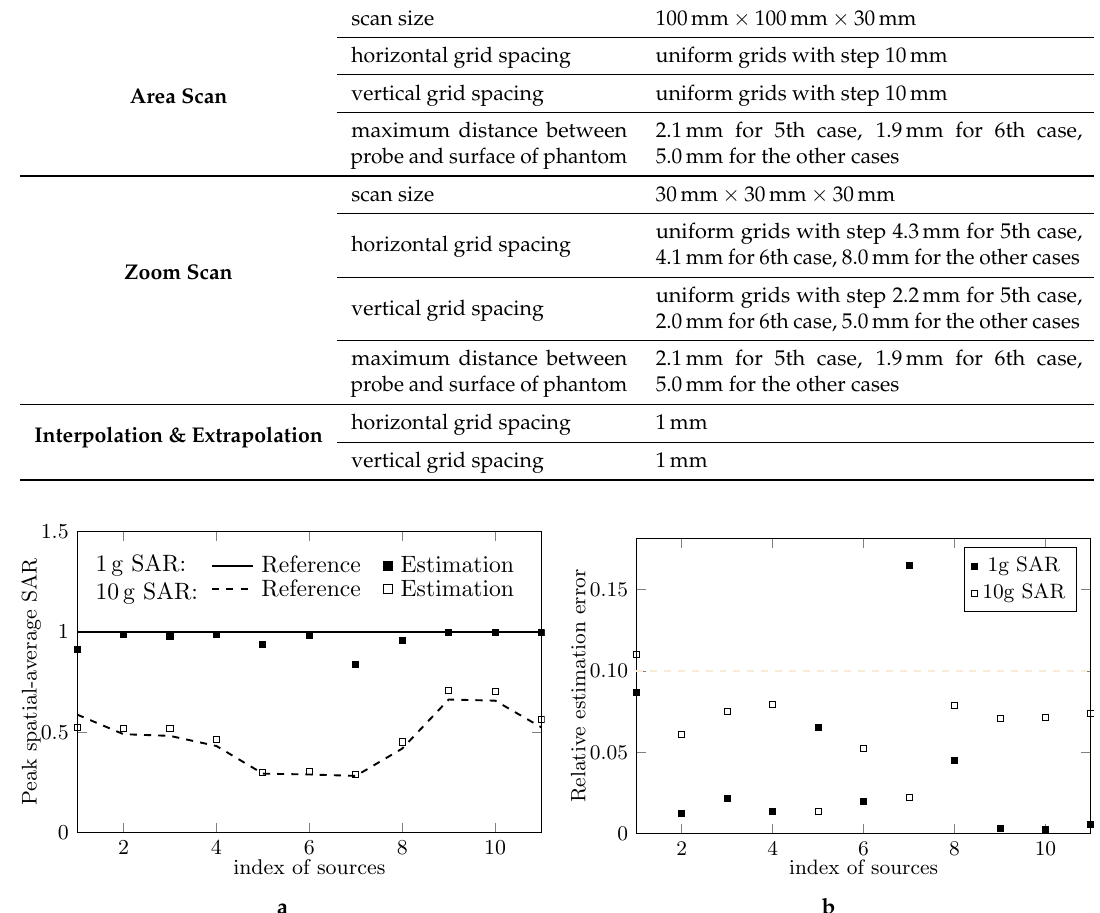
Figure 1. ( a ) Peak spatial-average SAR estimated by the traditional SAR measuring system with the setting in Table 1 and ( b ) associated relative estimation